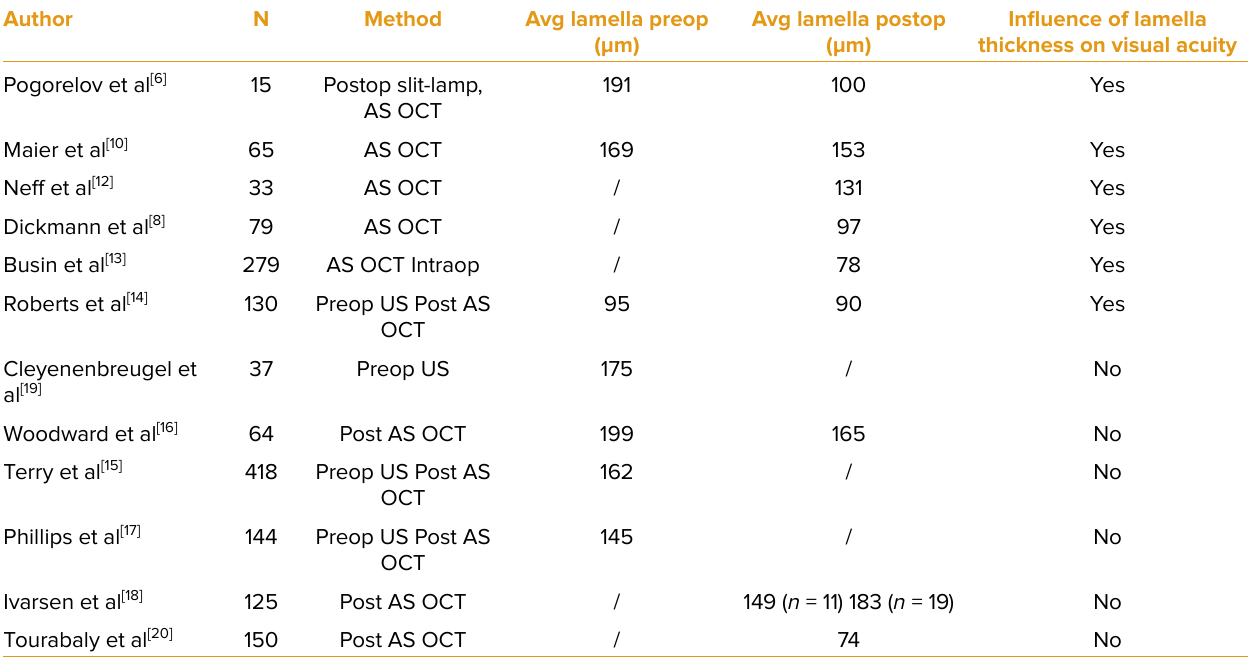
Table 1. Influence of lamella thickness on visual acuity with data regarding to the author, number of patients, method of measurement, and lamellar thickness.